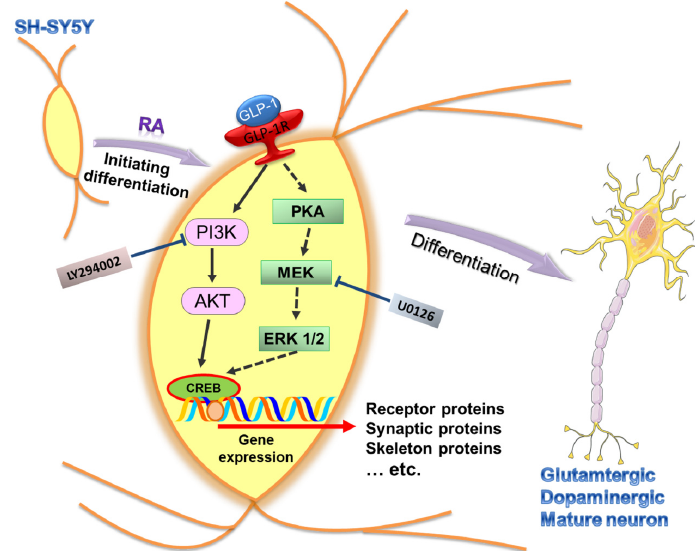
Figure 7. Schematic diagram illustrating the downstream signaling of activated GLP-1R for regulating the SH-SY5Y neuronal differentiation. The expression of GLP-1 receptors (GLP-1Rs) has been seen in human SH-SY5Y neuroblastoma cells and is involved in neuronal differentiation. Stimulation of GLP-1Rs triggers two downstream signaling axes, including PI3K-AKT (filled-line arrow) and PKA-ERK (dotted-line arrow). The specific inhibitors, LY294002 and U0126, were used to suppress the activity of PI3K and MEK, respectively. Our study’s overall results suggested that PI3K-AKT is the dominant downstream signaling axis regulating SH-SY5Y differentiation. In addition, the cells tend to develop into glutamatergic and dopaminergic neurons in GLP-1 induced neuronal differentiation. (RA: retinoic acid; cAMP: cyclic adenosine monophosphate; PKA: protein kinase A; MEK: mitogen-activated protein kinase kinase; ERK 1/2: mitogen-activated protein kinase 1 and 2; PI3K: phosphatidylinositide 3-kinase; AKT: protein kinase B; CREB: cAMP response element binding protein).